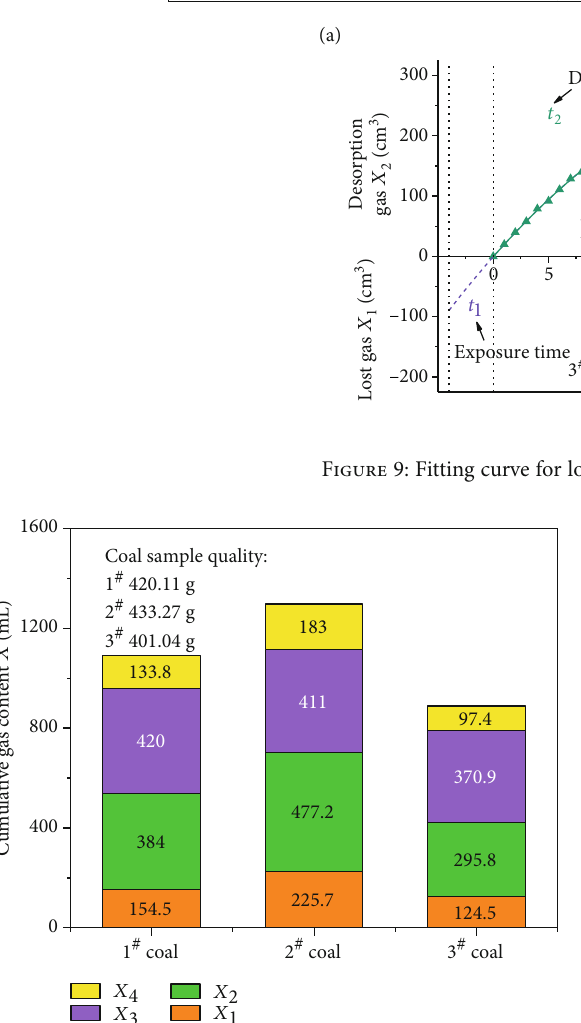
Figure 10: Gas content and coal quality for three coal measurements, the ball grinding tank was removed and the tank was cooled to ambient temperature before the coal sample was removed from the tank and weighed. Figure 10 for the coal samples considered. Based on equation (6), the gas contents Q of the 1 # , 2 # , and 3 # coal seams were calculated to be 2.60, 2.89, and 2 : 22 cm 3 · g − 1 , respectively.